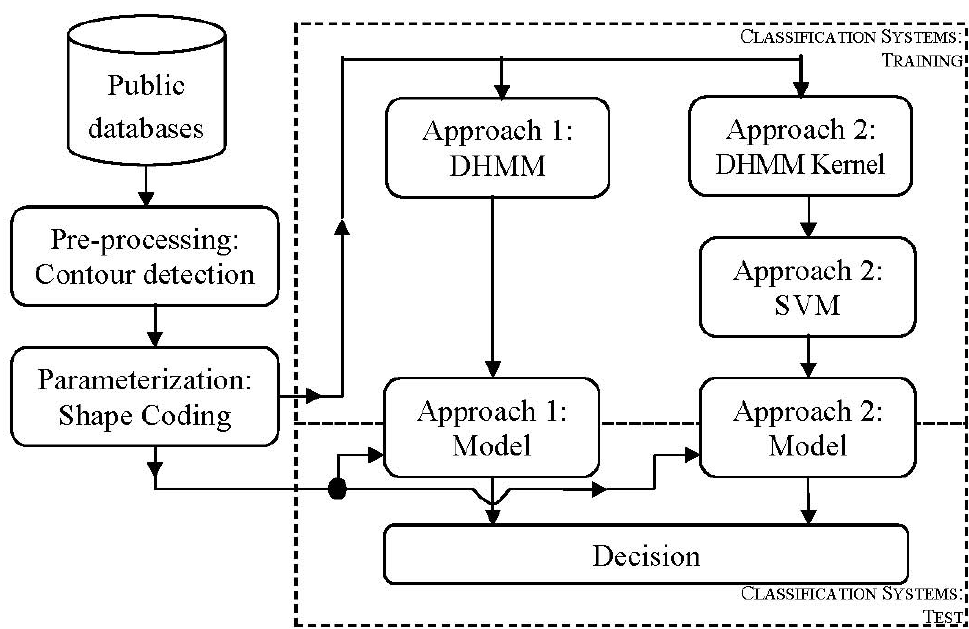
Figure 1. Flow chart of our